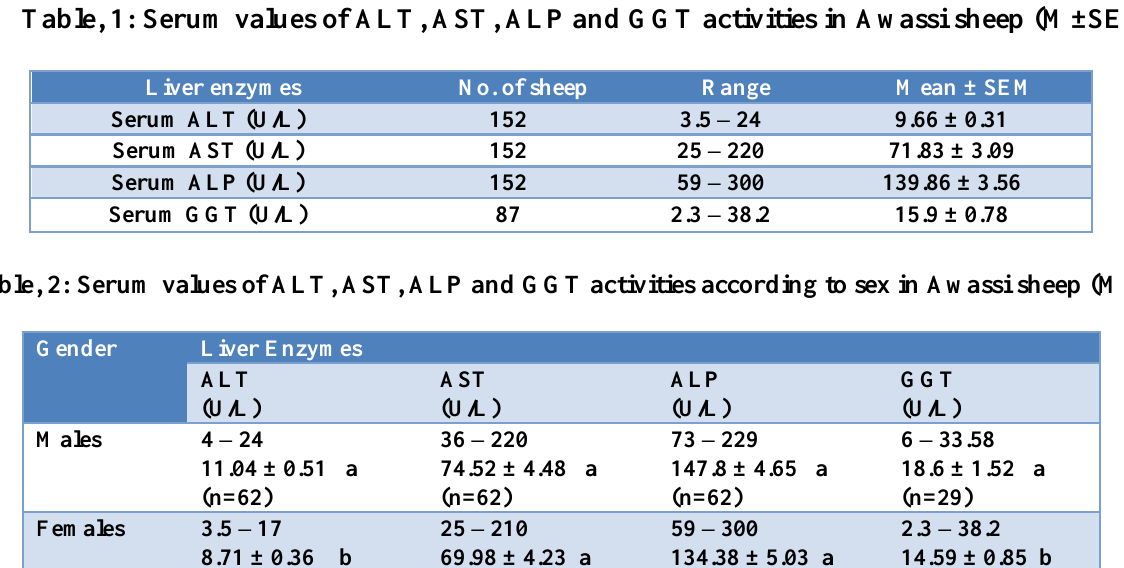
Different letters vertically refers to presence of significant differences at